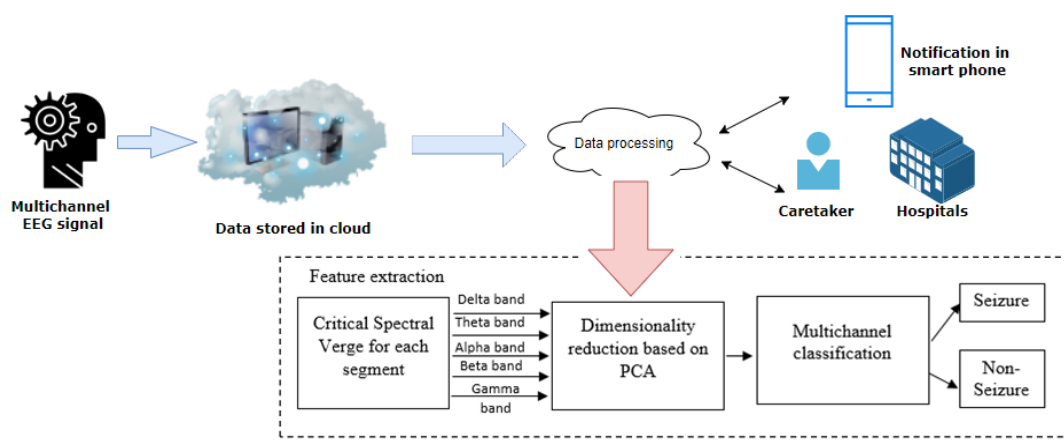
Figure 1. Block diagram of MCSV multichannel-based epileptic seizure classification.